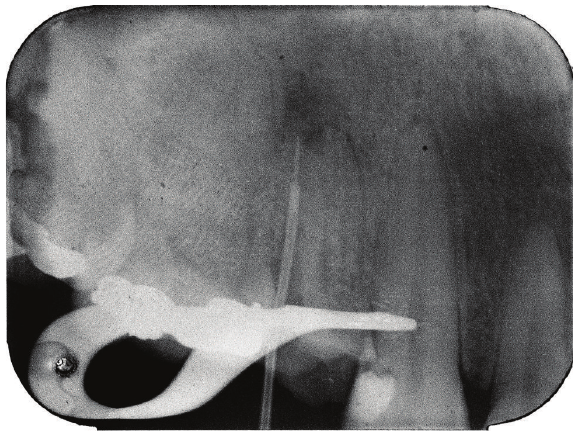
Figure 3: Periapical radiograph confirming the attachment of the fragment to the hypodermic needle.